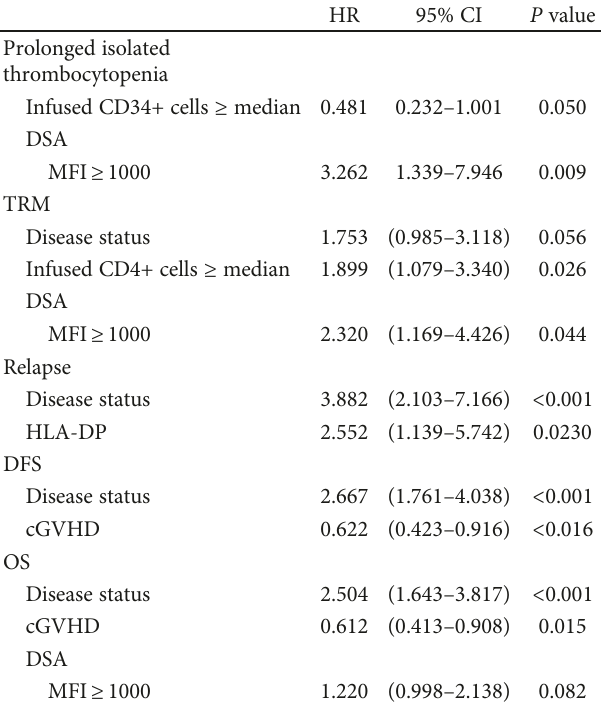
Table 4: Multivariate analysis of factors associated with transplant